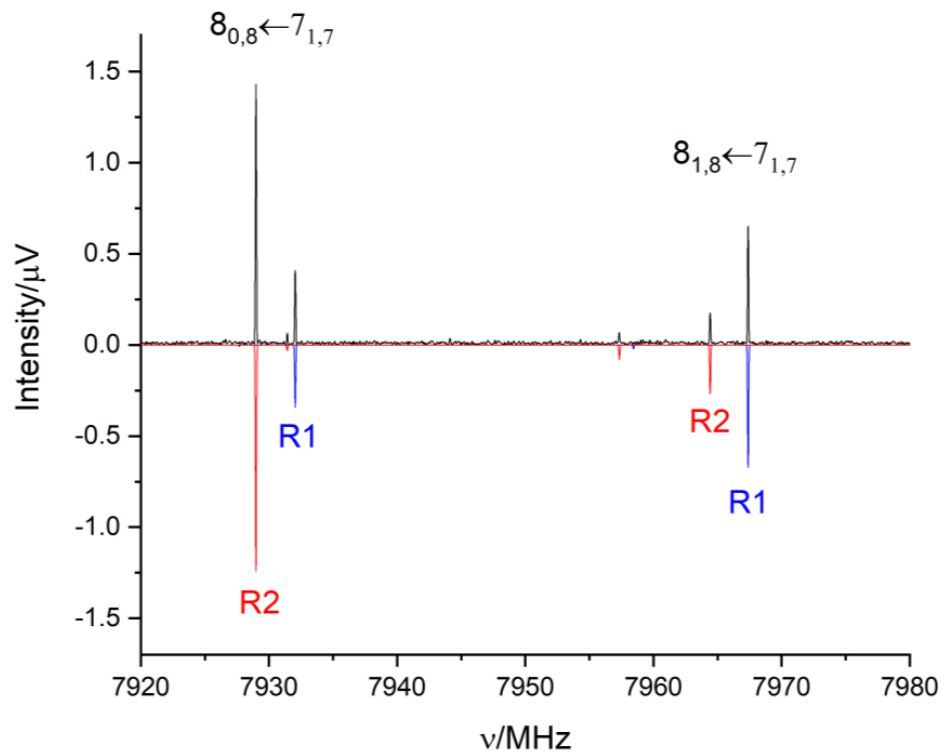
Figure 2. A section of the CP-FTMW spectrum of laser ablated GA showing the 8 1,8 ← 7 1,7 ( a -type) and 8 0,8 ← 7 1,7 ( b -type) transitions. The experimental spectrum (upper black trace) is compared with the spectrum predicted with the fitted rotational parameters (see Table 1) for rotamers R1 (lower blue trace) and R2 (lower red trace).